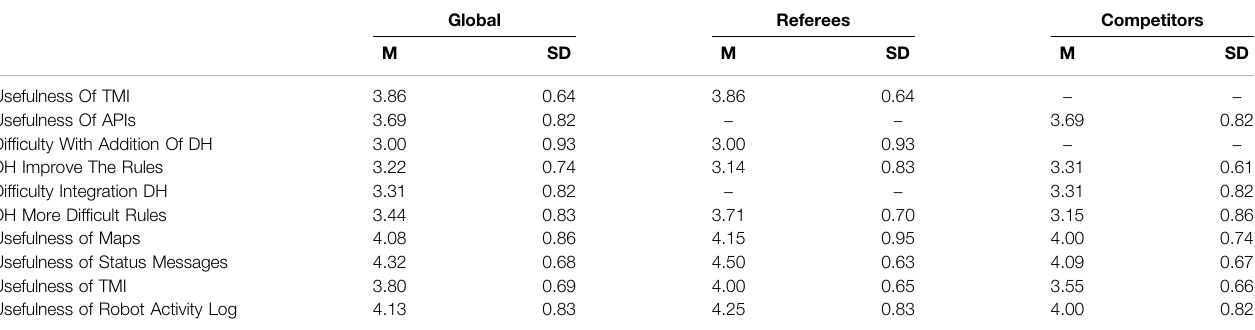
TABLE 2 | Summary of the results of the part two of the questionnaire. The table includes the mean (M) and the standard deviation (SD) of each question. The values are aggregated globally and by actor.